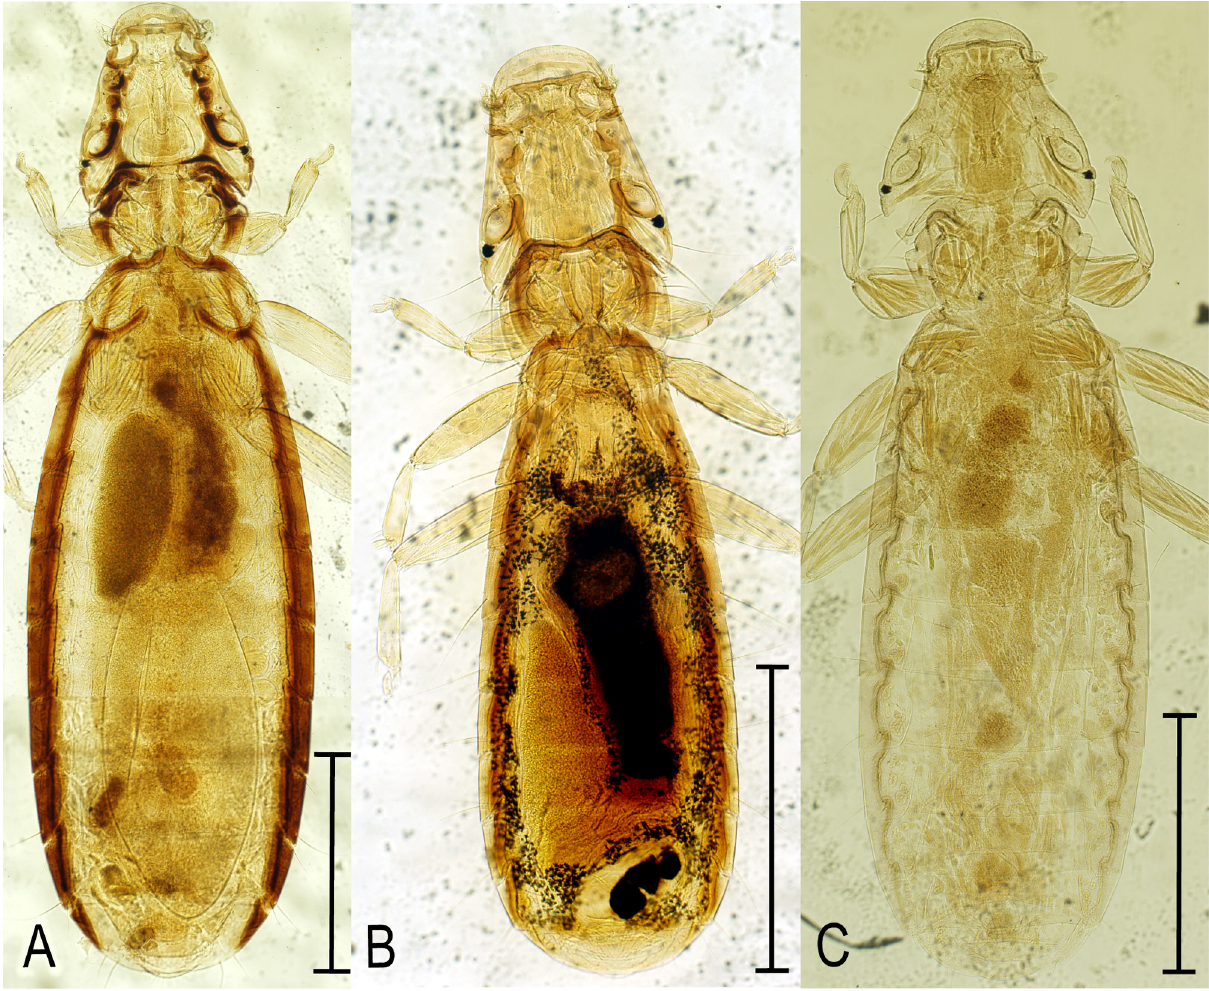
Figure 1. (A) Lectotype female of Ricinus ivanovi Blagoveshtchensky, 1951. (B) Lectotype female of R. tugarinovi Blagoveshtchensky, 1951. (C) Holotype female of R. vaderi n. sp. Scale bar: 1